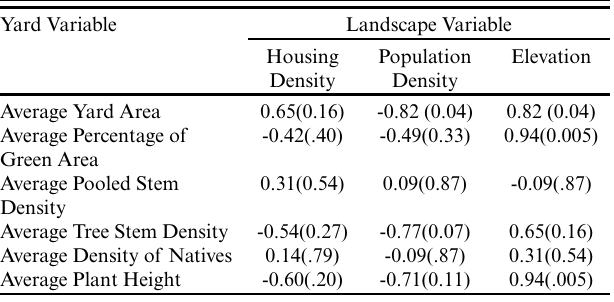
Table 3 . Spearman correlations coefficients between traits and landscape level parameters. Numbers in parentheses indicate p values.